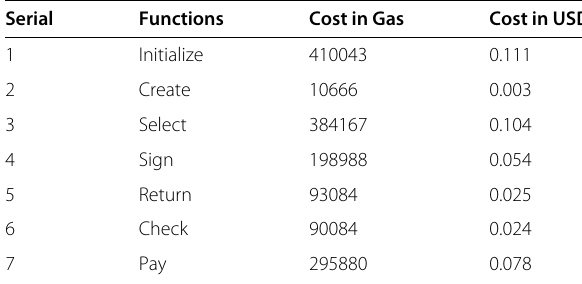
Table 4 Cost of using the smart contracts